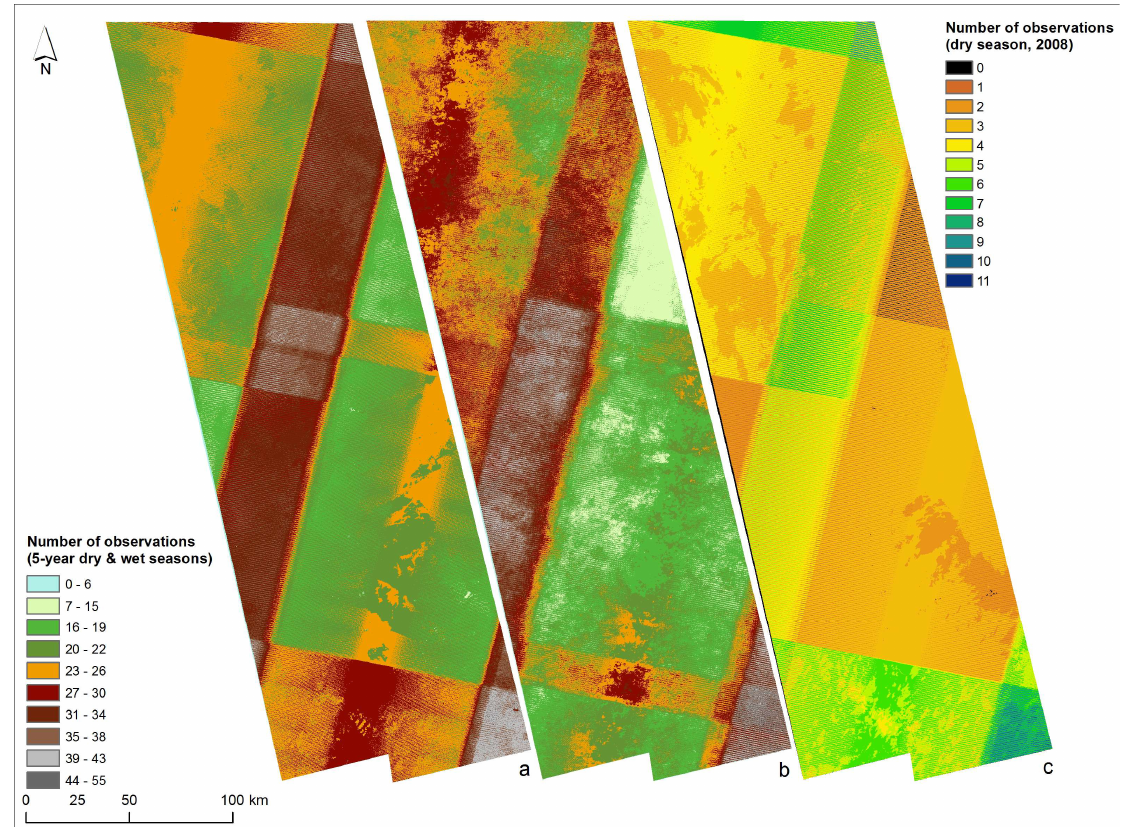
Figure 3. Number of Landsat Thematic Mapper (TM) and Enhanced Thematic Mapper + (ETM+) observations over the study area for: ( a ) the dry seasons of the years 2007–2011 (2 June–1 October); ( b ) the respective wet seasons (21 November–31 March), and ( c ) the dry season of the year 2008.